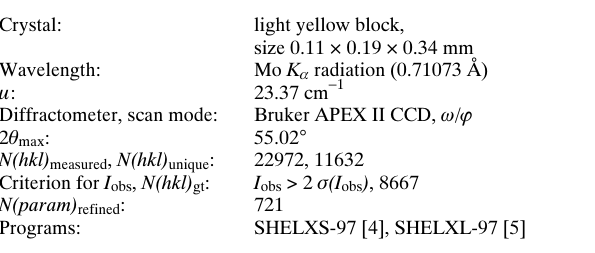
Table 1. Datacollection and